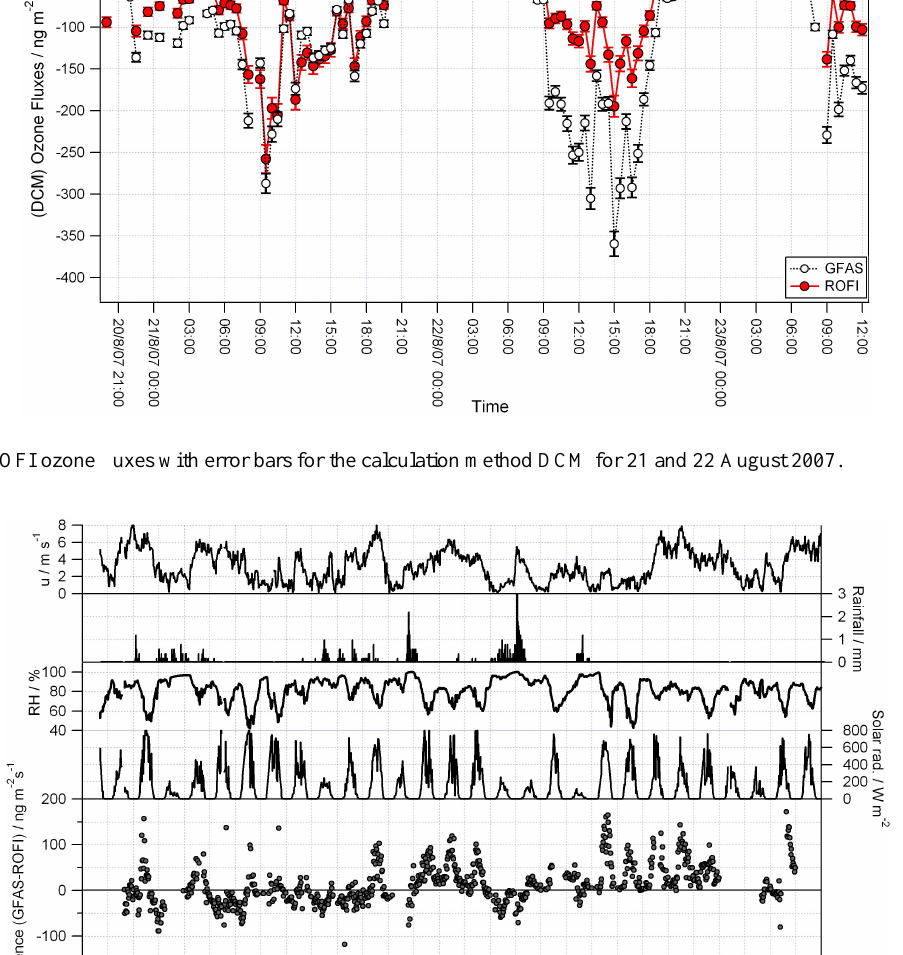
vertical wind speed fluctuation w 0 as the co-spectra